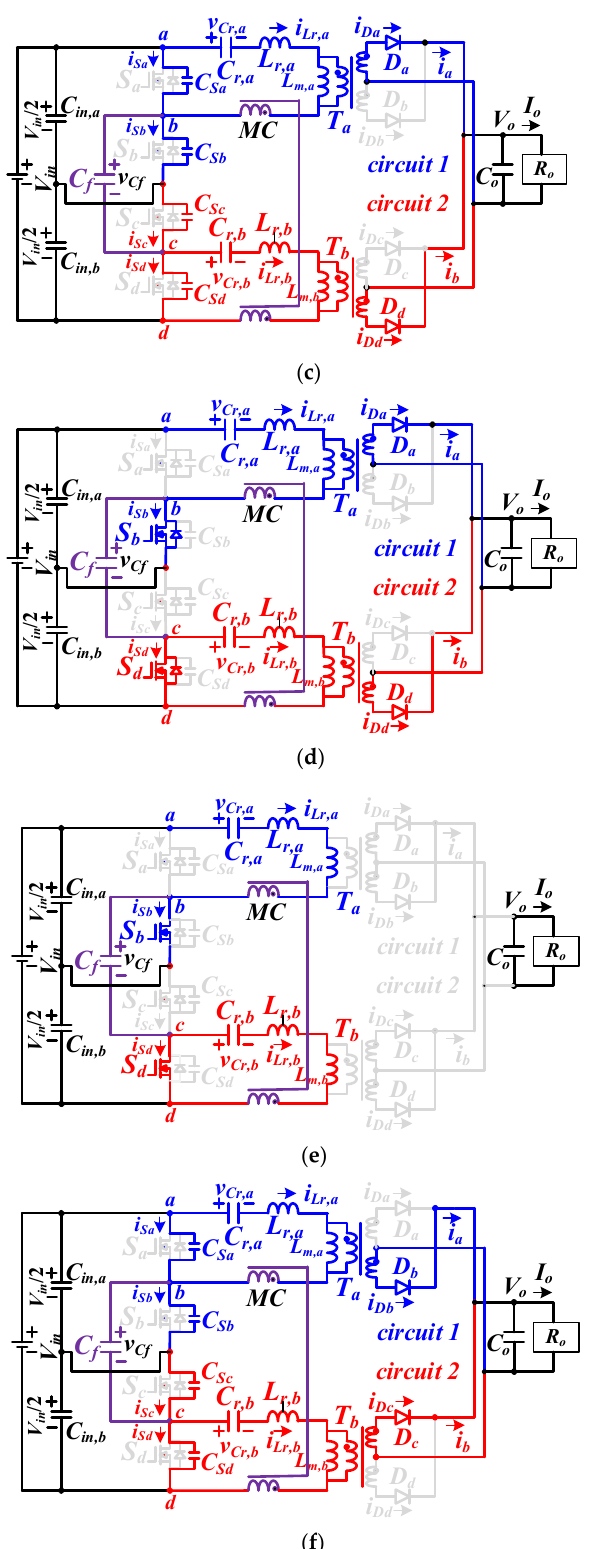
Figure 5. Equivalent circuits for each step ( a ) step 1, ( b ) step 2, ( c ) mode 3, ( d ) step 4, ( e ) step 5, ( f ) step